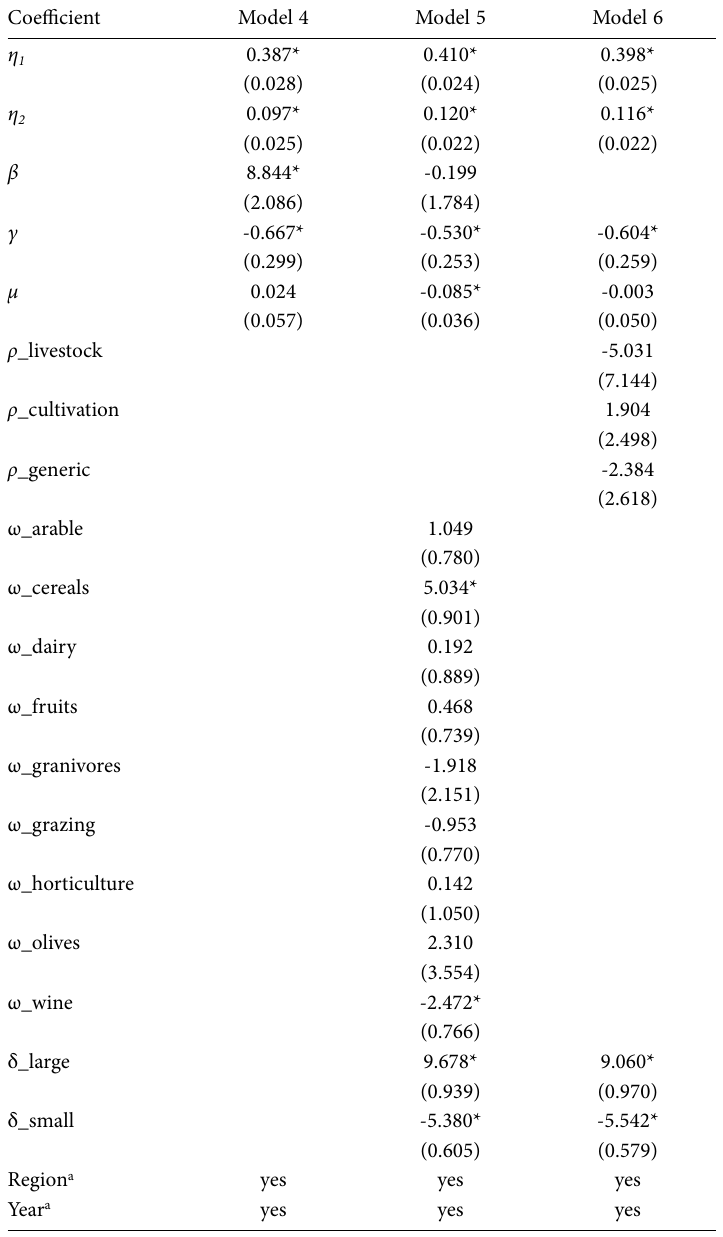
Table 8. GMM estimation of Models 4 to 6 (standard error in